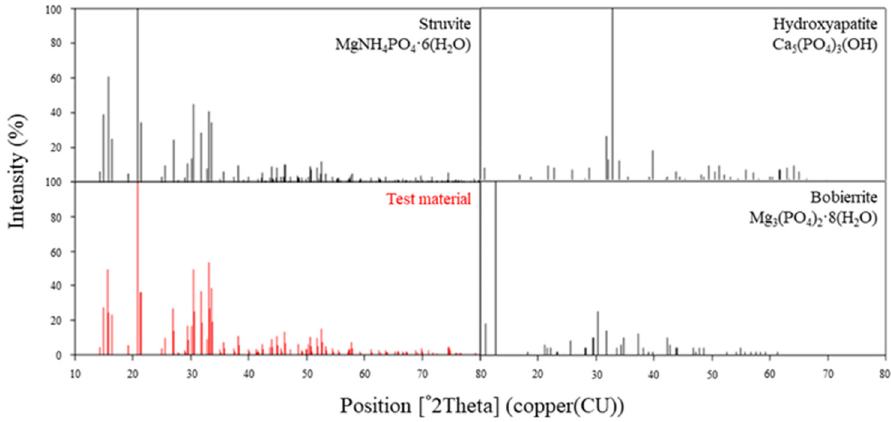
Figure 6. Result of XRD analysis of recovered material.